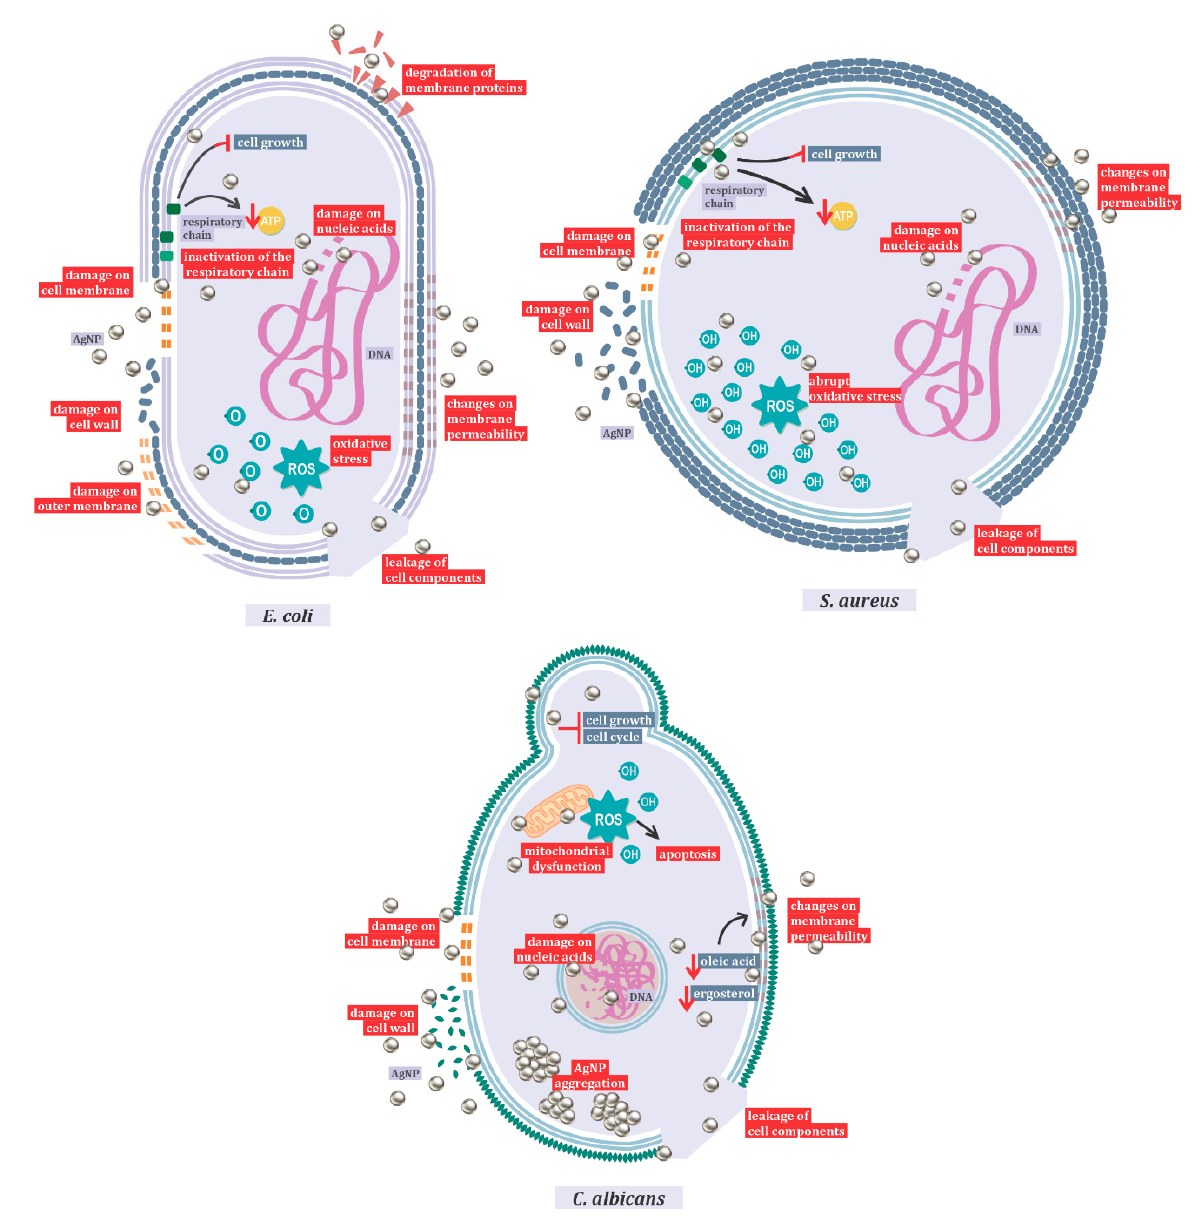
Figure 1. Mechanisms of action of AgNPs against Candida albicans , Escherichia coli, and Staphylococcus aureus .